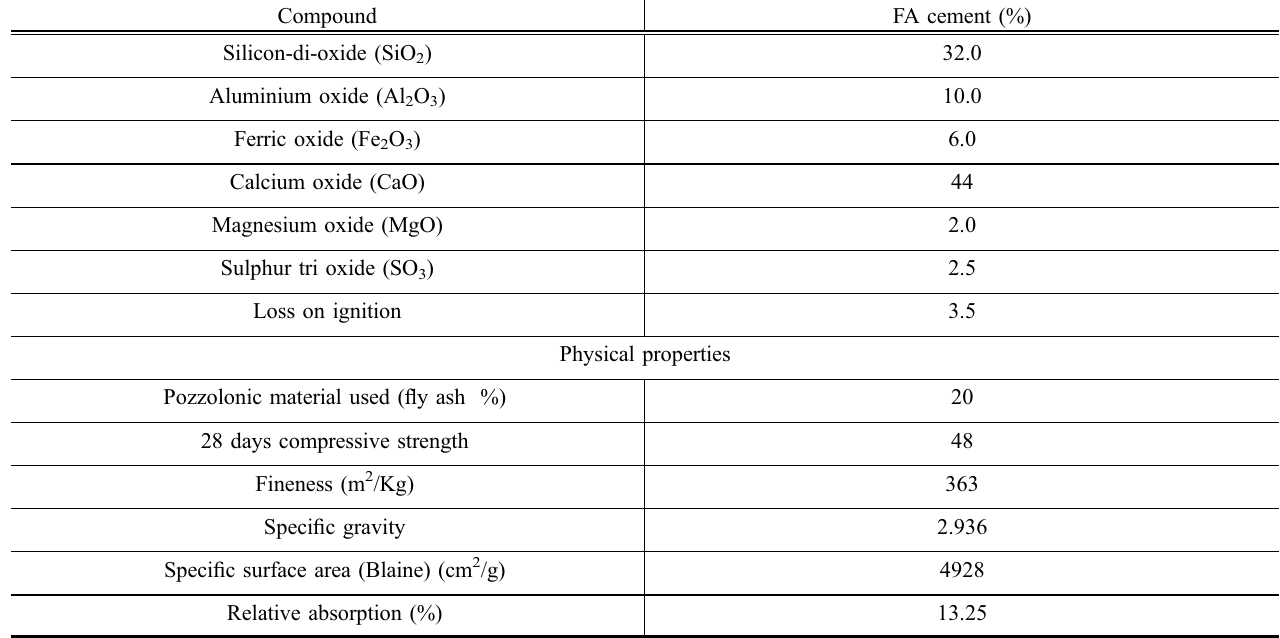
Table 1 Chemical compositions of PPC (FA